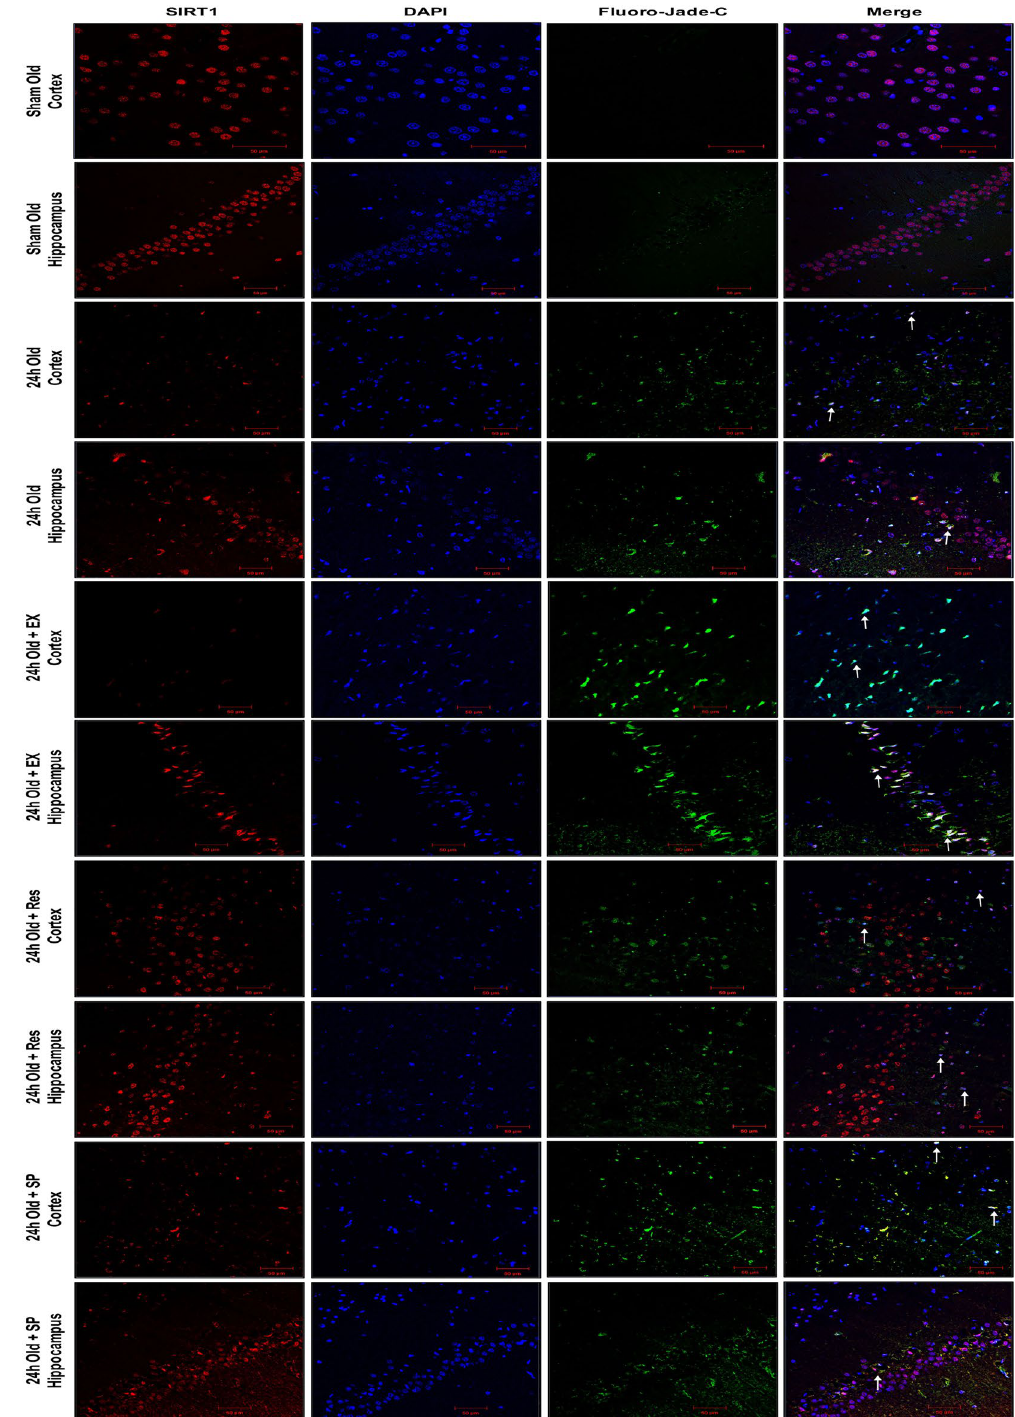
Figure 6. Immunofluorescence labeling of SIRT1 in brains of the aged experimental rat. Triple immunofluorescence staining is used to probe for SIRT1 (Red), DAPI (Blue), and Fluoro Jade-C (Green) to assess neurodegeneration in cortex and hippocampus neurons for control as well as brains from 24 h after MCAO, MCAO + EX-527, MCAO + resveratrol, and MCAO + SP600125 treatment. White arrows indicate co-localization of FJ-C with SIRT1 and DAPI (n = 4; Scale Bar—50